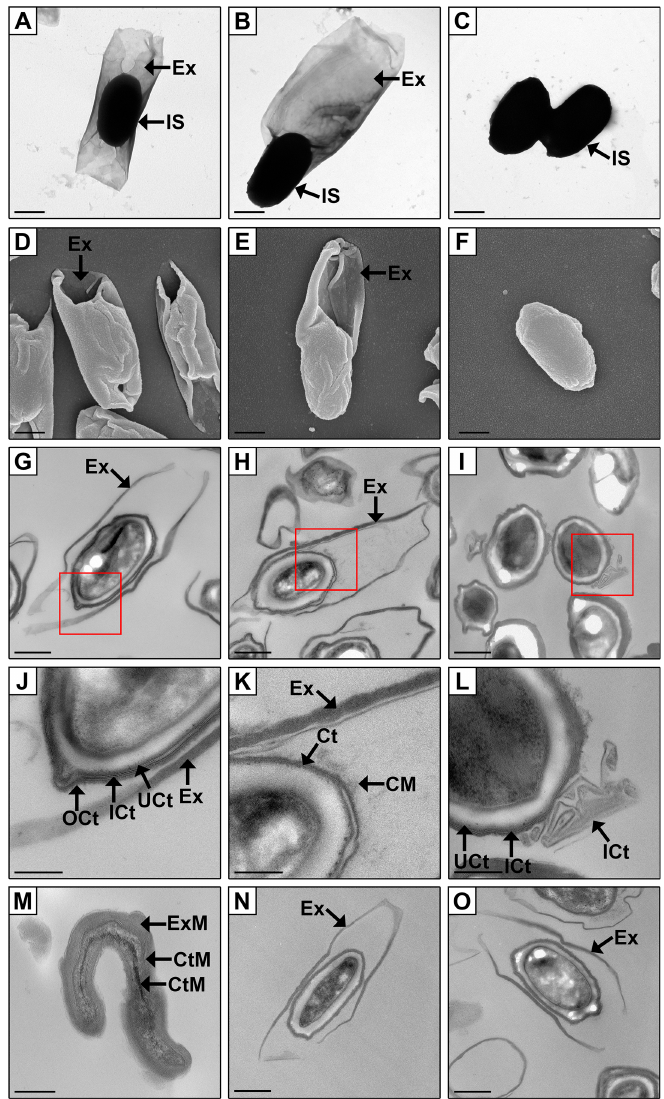
Fig 2. Electron microscopy imaging shows abnormalities in the exosporium and coat structures of the spore mutants. Whole spores were imaged by Transmission Electron Microscopy (TEM) (A-C) and Scanning Electron Microscopy (SEM) (D-F). Spore sections were imaged by TEM (G-O). Images J-L are magnified views of the red boxed areas shown in images G-I, respectively. Wild-type spores (A, D, G, J), csA mutant spores (B, E, H, K), csB mutant spores (C, F, I, L), detached exosporial and coat material present in the csB mutant spore sample (M), complemented csA mutant spores (N), complemented csB mutant spores (O). In the wild-type strain the inner spore (IS) is centralised within the exosporium (EX). The spore coat (Ct) forms part of the inner spore (IS) and in the wild-type strain is composed of three layers (OCt, ICt, UCt). Ex, exosporium; IS, inner spore; Ct, coat; OCt, outer coat; ICt, inner coat; UCt, under coat; ExM, exosporial material; CtM, undefined coat material. Scale bar: images A-I, N-O = 0.5 μm; images J-M = 0.2